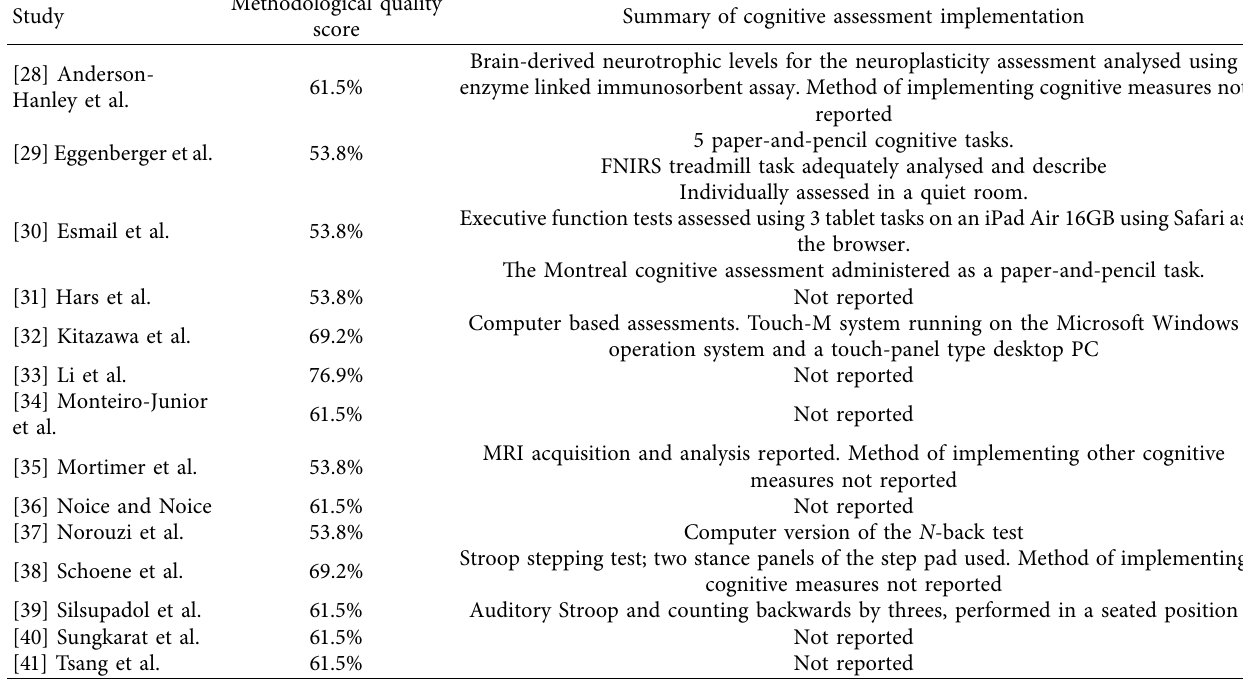
Table 1: Methodological quality and reporting transparency of the included